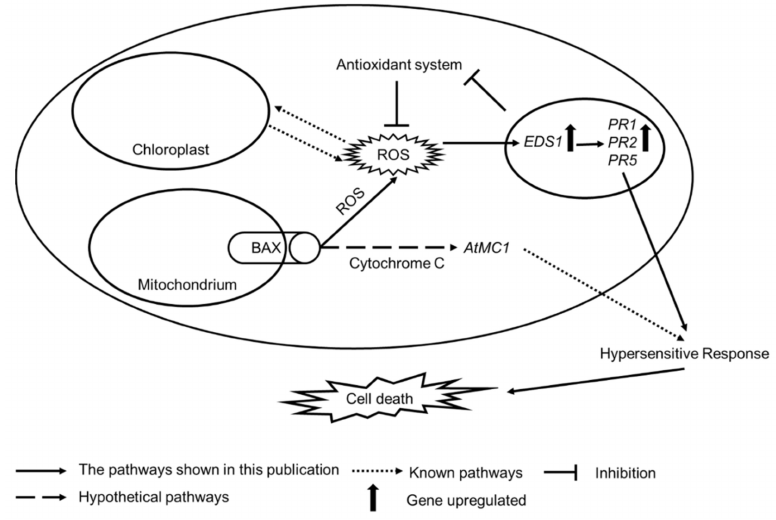
Figure 7. Proposed model of plant (EDS1) and animal (Bax) proapoptotic dependency in the cell death process in an artificial system used in this study: analogous to animal cells, the Bax protein in plant cells is located in the mitochondrial membrane [8,17]. It leads to the outflow of mitochondrial content (including ROS) to the cytoplasm. This so-called first ROS wave can act not only as a signal but also as a damaging factor to the chloroplast membranes, leading to the generation of a second ROS wave derived from chloroplasts. H 2 O 2 induces EDS1 expression in the nucleus [60]. EDS1 is required for PATHOGENESIS-RELATED (PR) protein accumulation. PR proteins trigger HR and, as a consequence, cell death [32]. Moreover, EDS1 acts as a negative regulator of the antioxidant system and thus contributes to increasing ROS content in plant tissues [22]. Furthermore, expression of mammalian Bax may lead to cytochrome C outflow to the cytoplasm and the activation of plant metacaspases. Some metacaspases, such as AtMC1, induce cell